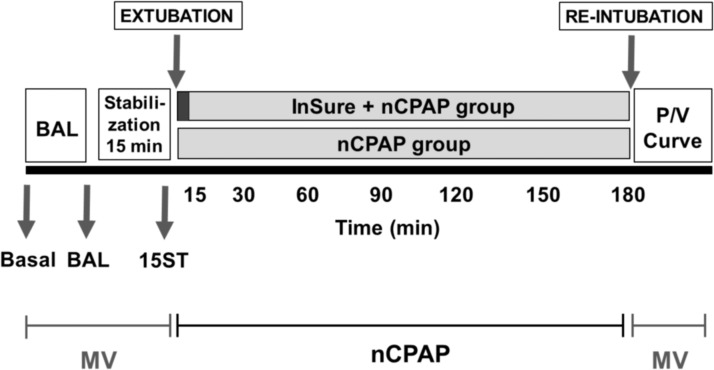
Scheme of the experimental set up.Scheme of the steps followed during the experimental procedure. Animals were intubated at baseline (Basal) and underwent several broncho-alveolar lavages (BAL) in order to induce surfactant depletion. A 15 min stabilization period was established to confirm the respiratory distress (15ST). In this period, animals were managed on mechanical ventilation (MV). After the respiratory distress was confirmed, animals were randomized to one of the experimental groups. Rabbits in the nCPAP group were maintained on nCPAP for 180 min. Rabbits in the InSurE group received 200 mg/kg of Curosurf® and were then managed on nCPAP for 180 min. At the end of the experiment all rabbits were re-intubated to determine the pulmonary status. Post mortem a pressure/volume curve (P/V) was performed.